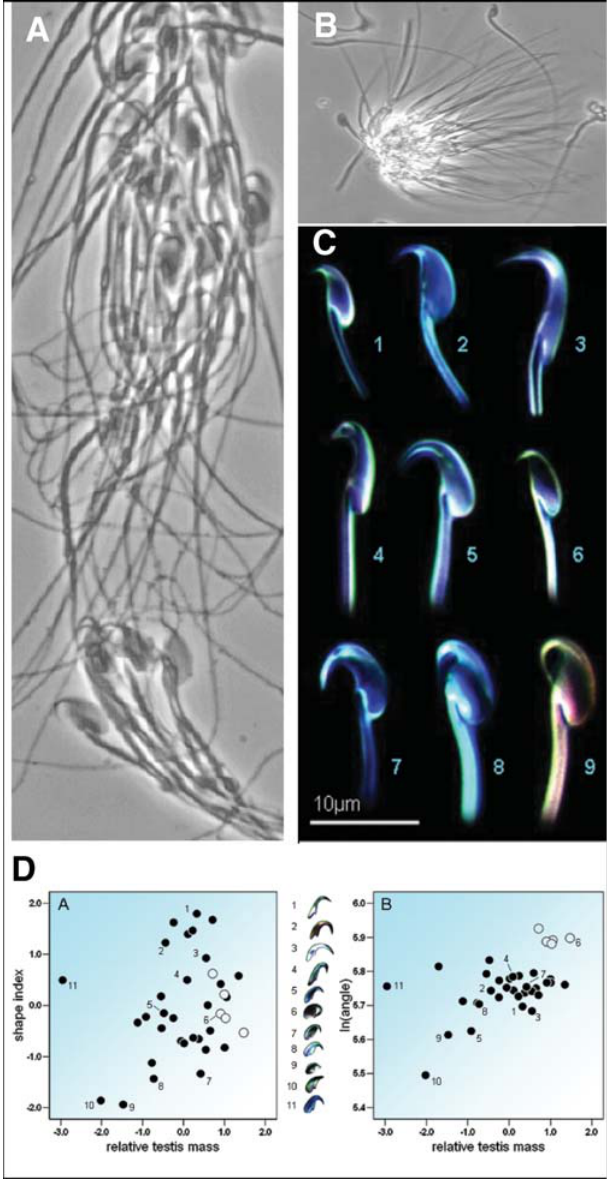
Figure 2. Sperm Trains in Rodents (A) Wood mouse A. sylvaticus sperm train where sperm are attached hook-to-hook or hook-to-fl agellum (credit: Harry Moore). (B) Motile grouping of wood mouse sperm (credit: Harry Moore). (C) Apical hook morphology across different species of rodents (1, Bunomys fratrorum ; 2, M. musculus ; 3, R. norvegicus ; 4, Dasymys incomtus ; 5, Pseudomys oralis ; 6, Maxomys surifer ; 7, Melomys burtoni ; 8, A. sylvaticus ; 9, A. speciosus ). From [10]. (D) The shape (left graph) and curvature (right graph) of the apical hook across different species of murid rodents in relation to the level of sperm competition (relative testes mass). From